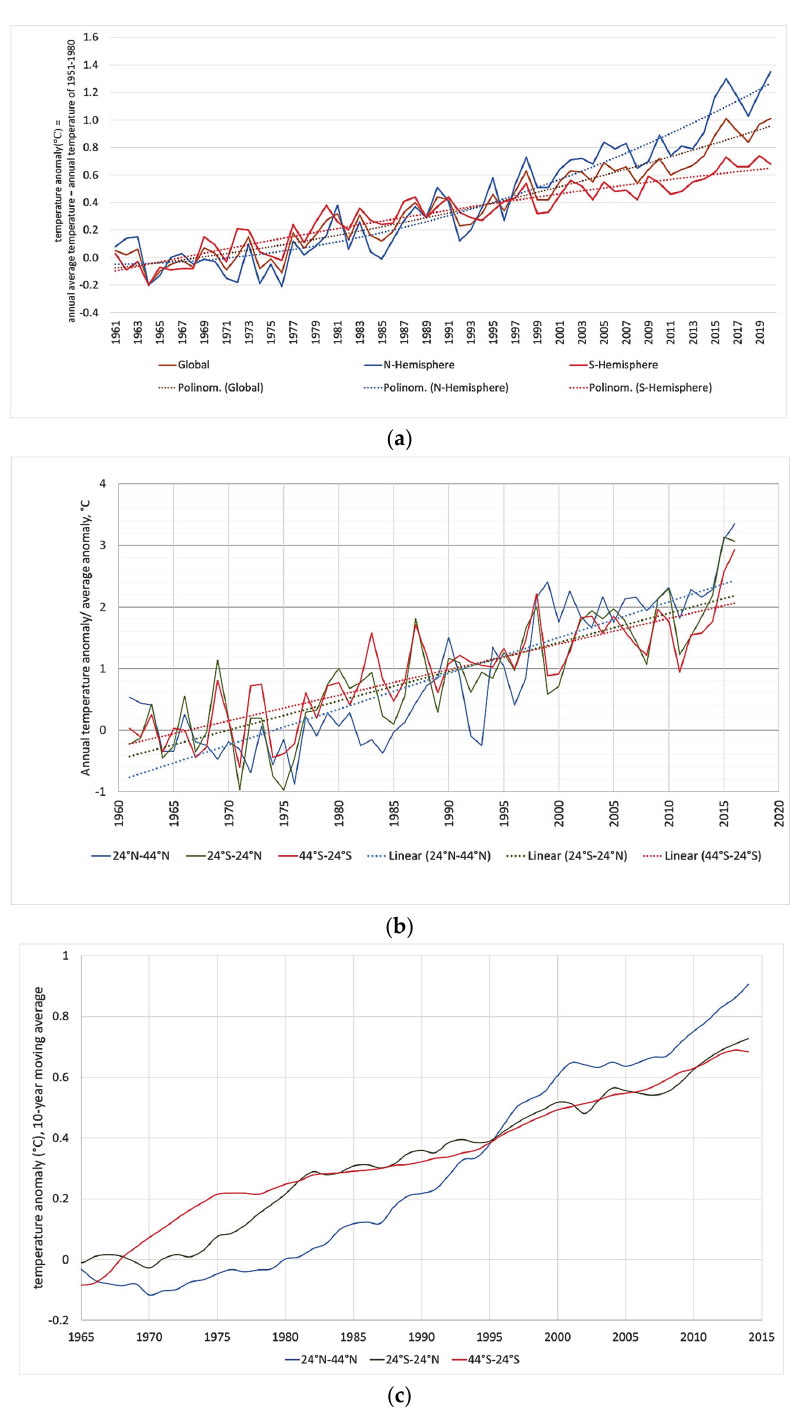
Figure 2. ( a ) Global temperature anomalies (annual mean temperature − mean temperature of 1951–1980). ( b ) Normalized annual temperature anomalies and their linear trends for the coffee ‐ producing latitudes. ( c ) Ten ‐ year moving averages of temperature anomalies for the coffee ‐ producing latitudes. Source: authors’ own construction based on data from [51].